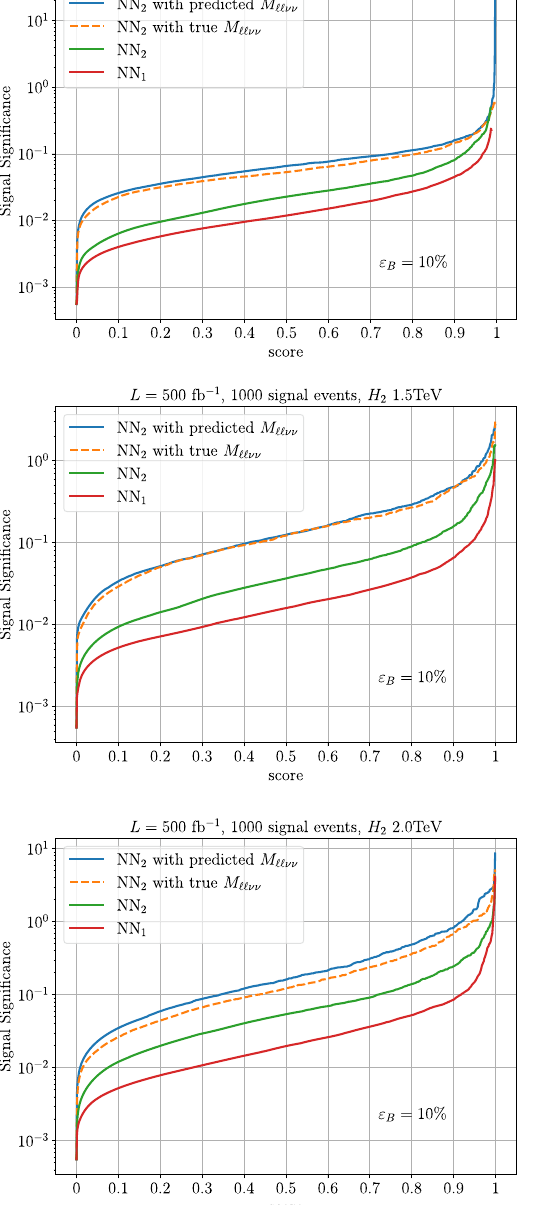
Fig. 12 Thestatisticalsignificanceofthe k NNNNalgorithmasafunc- tion of the cut on the output score (left panels) and the gain in the sig- nificance, Eq. (9), compared to the NN 1 classifier (right panels) for a 1